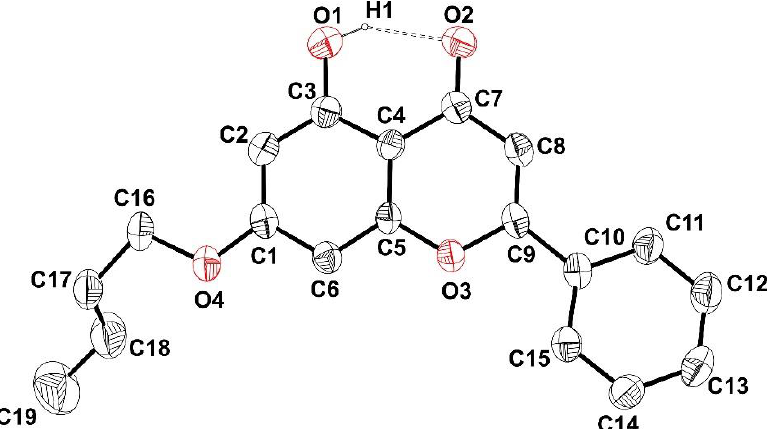
Figure 3. ORTEP representation of HL2 (ellipsoids at the 30% probability). Hydrogen atoms have been omitted for clarity.